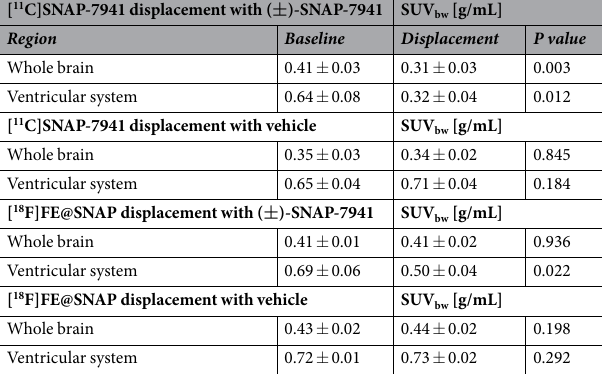
Table 2. Radiotracer uptake in the whole brain and the ventricular system. SUV bw mean values for the radiotracer uptake in the whole brain and the ventricular system of [ 11 C]SNAP-7941 and [ 18 F]FE@SNAP, both before and after displacement with either 15 mg/kg ( ± )-SNAP-7941 or vehicle with corresponding P values. Data in the table are expressed as mean ± SEM from independent experiments (n ≥ 3). Differences between baseline and displacement conditions were tested using a two-tailed parametric paired t-test. Values of P < 0.05 were considered as statistically